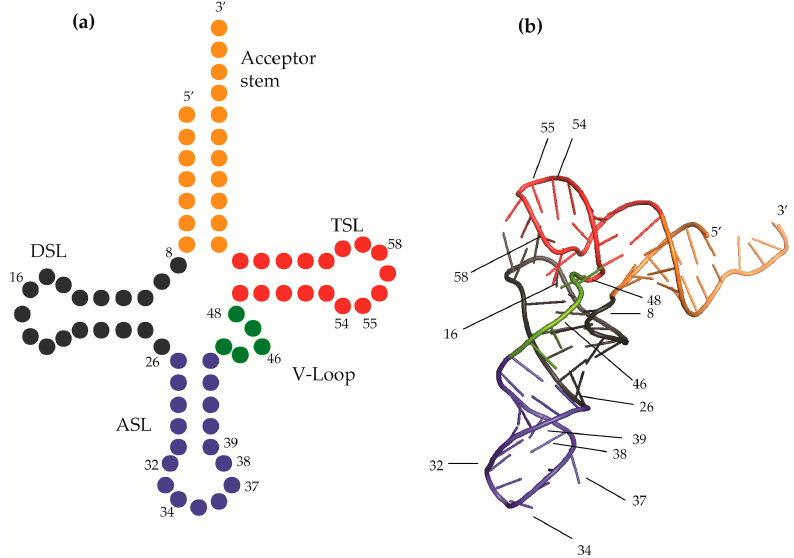
Figure 1. Transfer RNA (tRNA) secondary and tertiary structure. Yeast initiator tRNA cloverleaf structure (Left) and three-dimensional L-shape structure (Right) are shown with selected modification sites labeled. The colors correspond to the acceptor stem (orange), D stem and loop (DSL) domain (gray), T stem and loop (TSL) domain (red), anticodon stem and loop (ASL) domain (blue), and variable loop (V-Loop) domain (green). Three-dimensional figure adopted from Protein Data Bank (PDB) file 1YFG [16]. Weakly binding Mg 2+ ions are key to the folding of tRNA, as they are to all RNAs. They are shown in Figure 3. One Mg 2+ binding site is in the loop of the ASL and often found in the vicinity of ASL modifications.